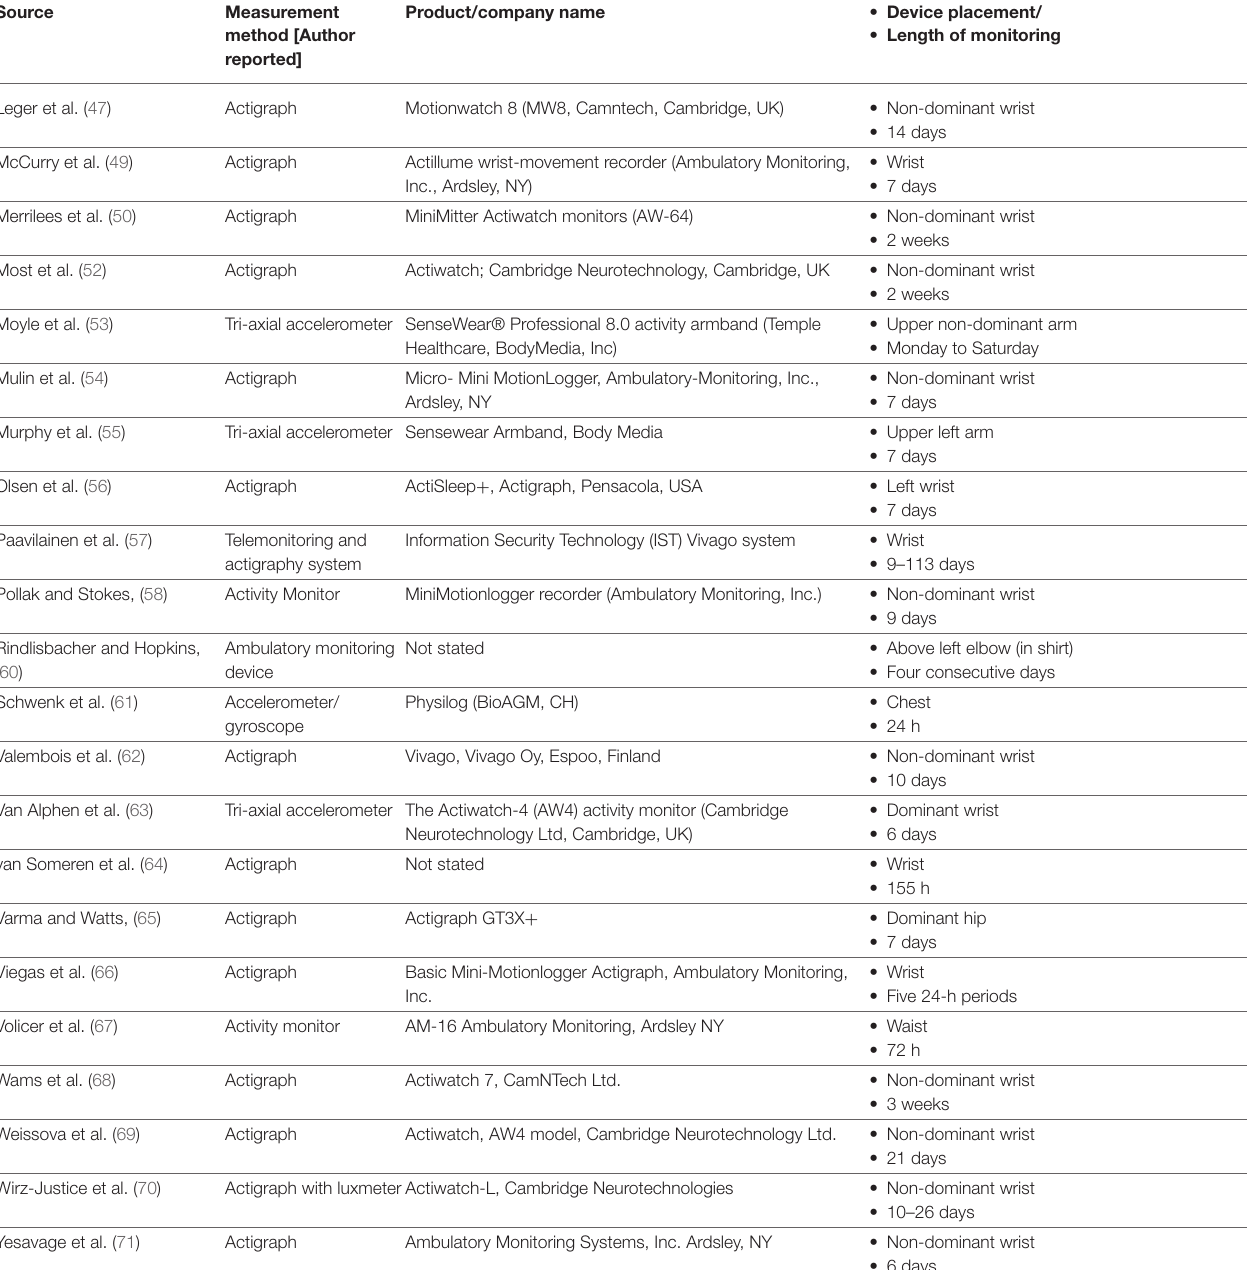
and M10 (mean difference, − 0.61; 95% CI, − 1.16 to − 0.06) (Dementia: n = 184, Control: n = 103) ( Figure 2E ) outcomes. Participants with dementia had statistically significantly higher mean values than controls on IV (mean difference, 0.46; 95% CI, 0.27–0.65) (Dementia: n = 245, Control: n = 171) ( Figure 2B ) and L5 (mean difference, 0.38; 95% CI, 0.15–0.61) (Dementia: n = 184, Control: n = 103) ( Figure 2D )